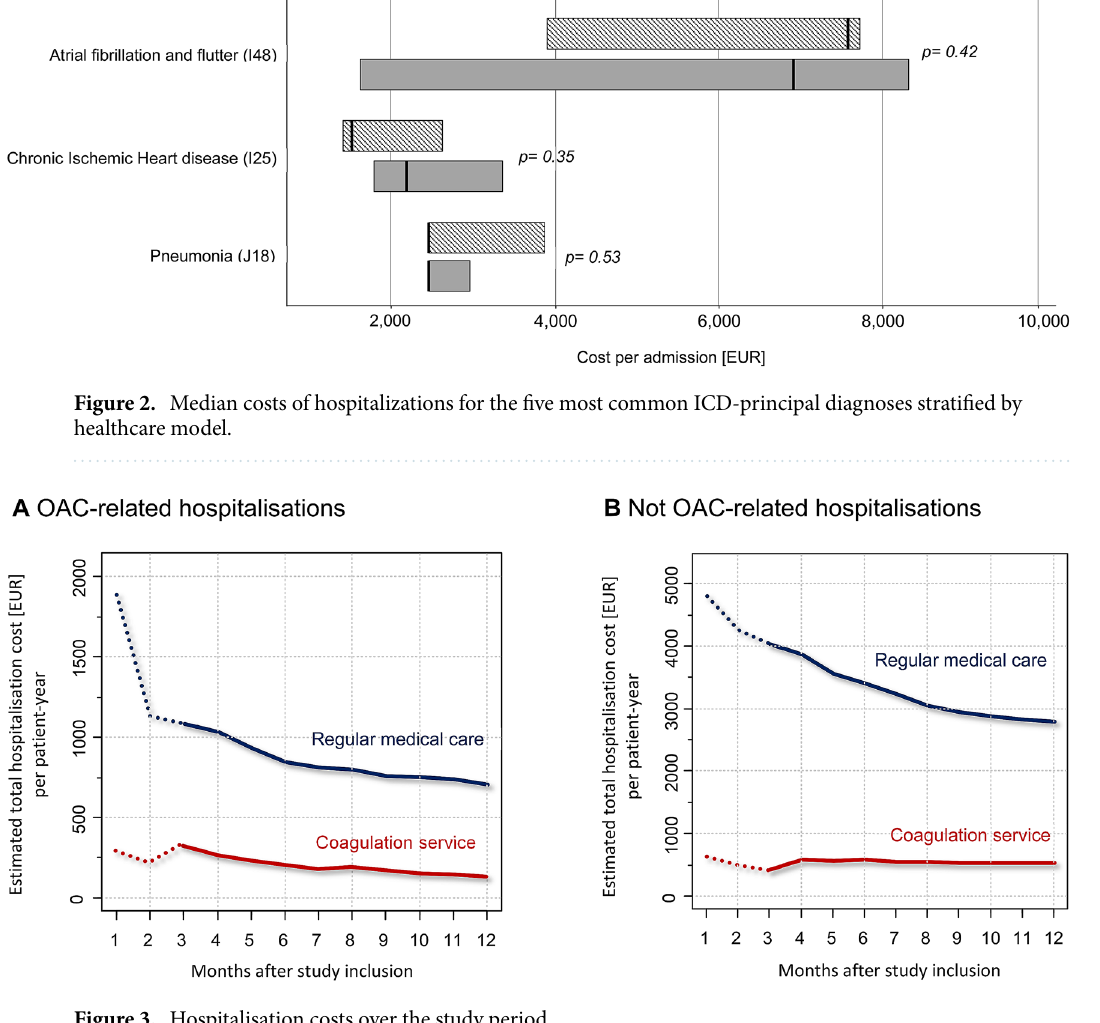
Figure 3. Hospitalisation costs over the study